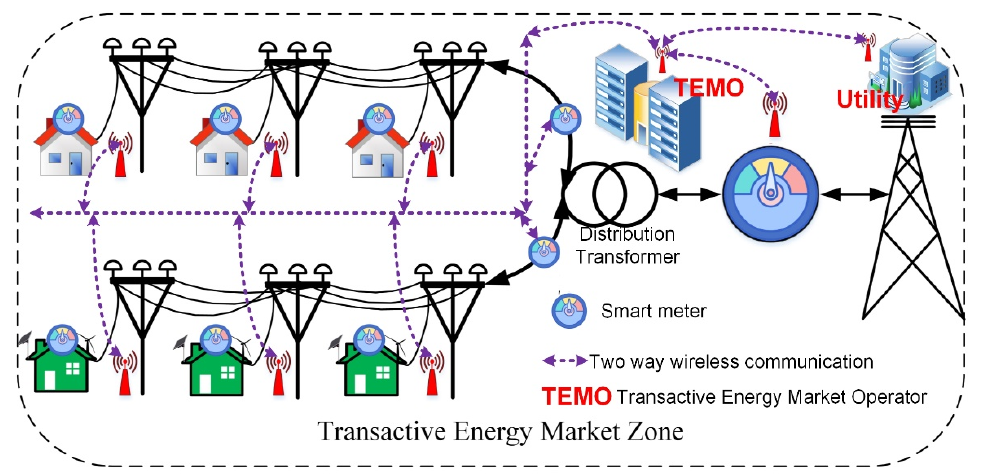
Figure 1. Architecture of proposed P2P energy market.